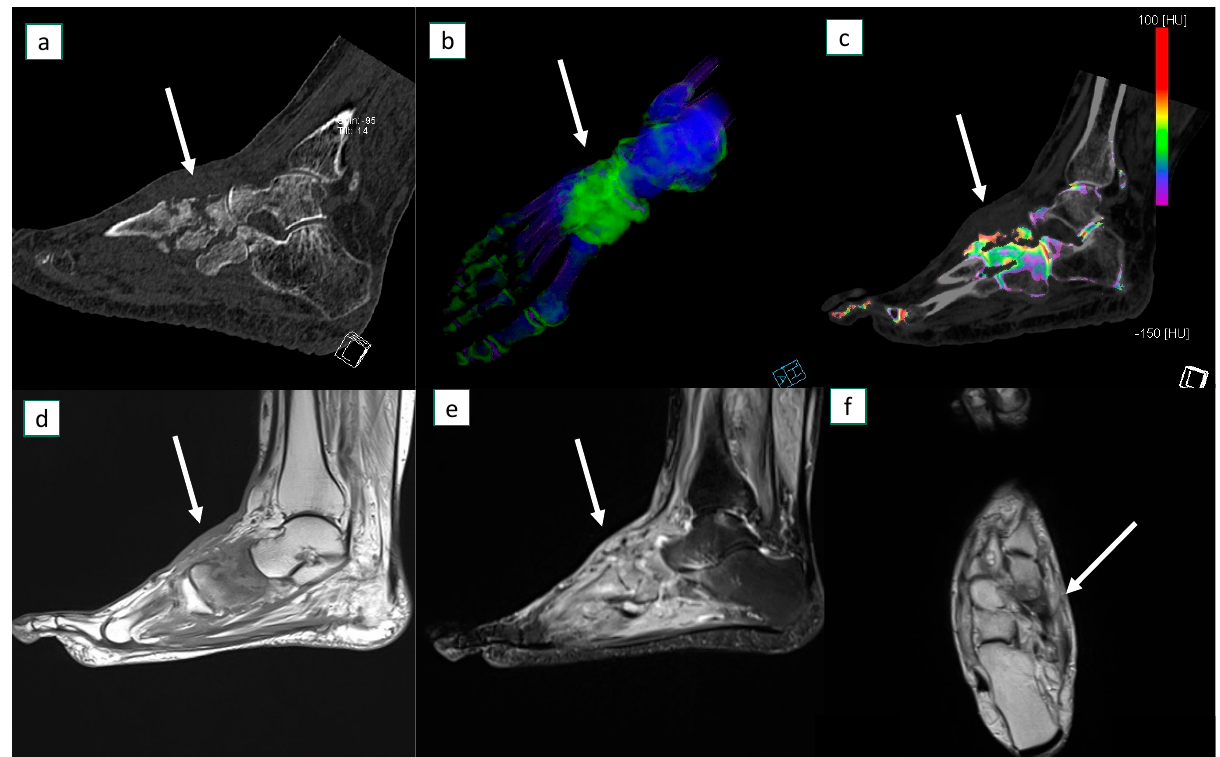
Figure 3. A 45-year-old female presented with acute atraumatic left foot pain and was diagnosed with osteomyelitis at bone biopsy. At dual-energy CT in sagittal plane there is evidence of advanced cortical erosions ( a ). At bone marrow edema analysis on 3D map ( b ) and sagittal 2D reconstruction image ( c ), diffuse bone marrow edema (arrows) can be identified around the midfoot. MRI sagittal T1 sequence ( d ), STIR sagittal ( e ), and T1 axial ( f ) images confirm the corresponding diffuse marrow edema (arrows) and extensive soft tissue edema.